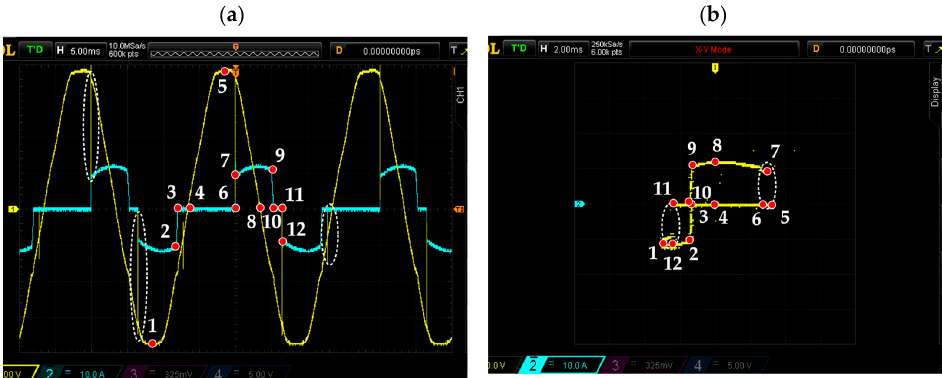
Figure 15. Recorded voltage and current waveforms of the grid side ( a ) and corresponding u–i characteristic ( b ) of the semiconverter. Firing angle 𝛼 = 90° .